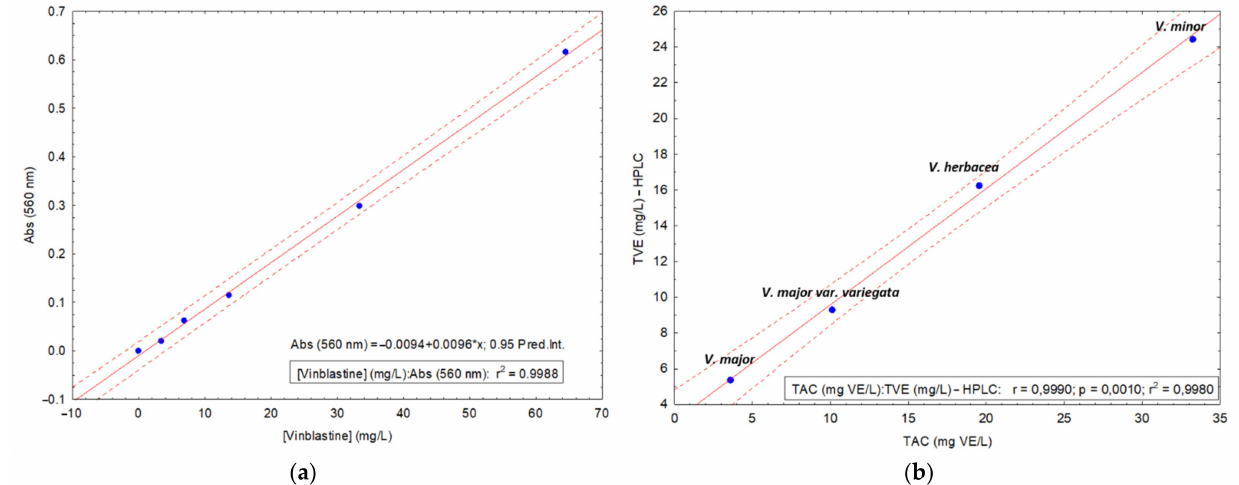
Figure 3. ( a ) Calibration curve of the proposed Dragendorff assay with vinblastine as a standard; ( b ) graphical correlation between Dragendorff TAC and HPLC calculated Total Vincamine